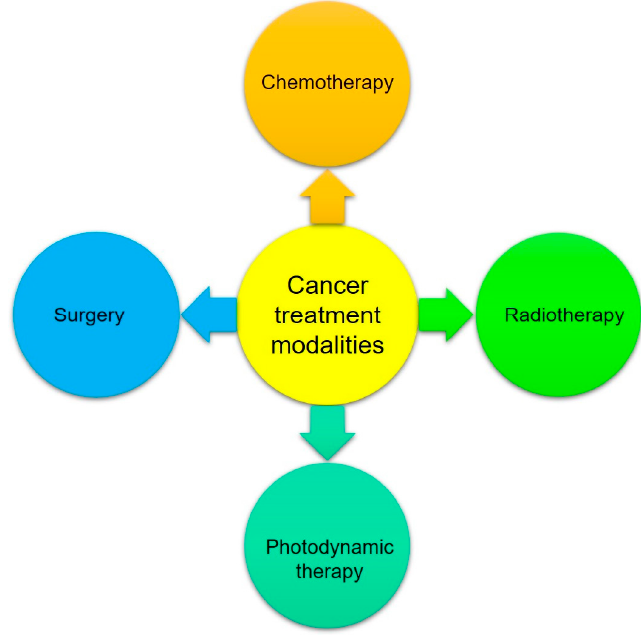
Figure 5. Fundamental and significant cancer treatment modalities.